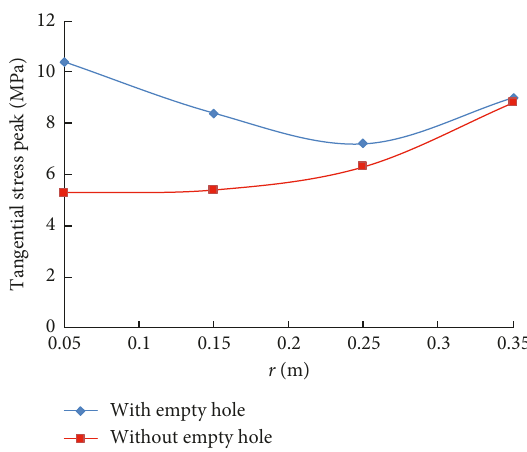
Figure 10: Empty-hole effect during stress wave propagation.